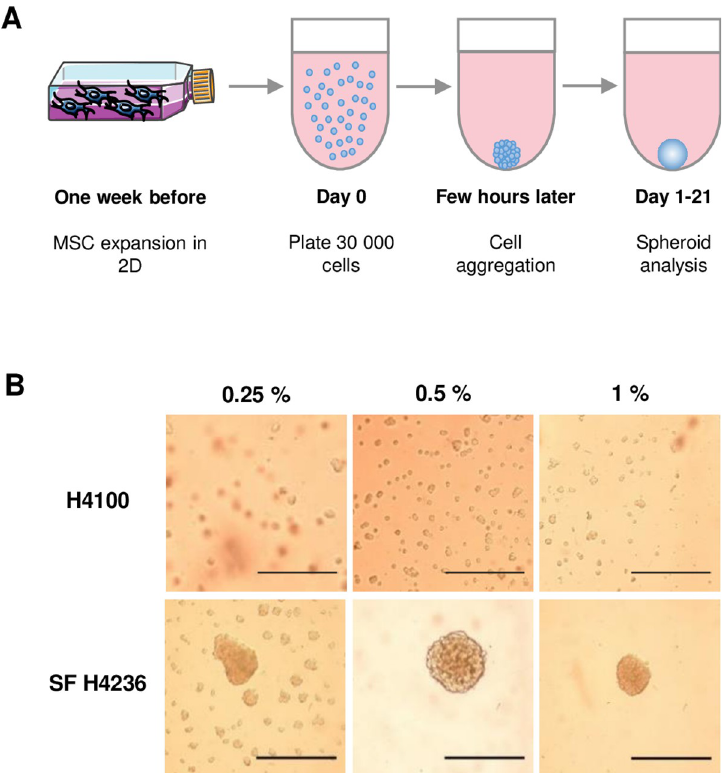
Fig 1. Spheroids formation from primary hMSCs. (A) Schematic representation of experimental plan. (B) 30,000 primary hMSCs per well were seeded into U-bottomed 96-well in medium containing 0.25%, 0.5% or 1% of methylcellulose (Methocult TM H4100 or SF H4236). Microscopy analysis was performed after 24 h (scale bars = 500 μ m).